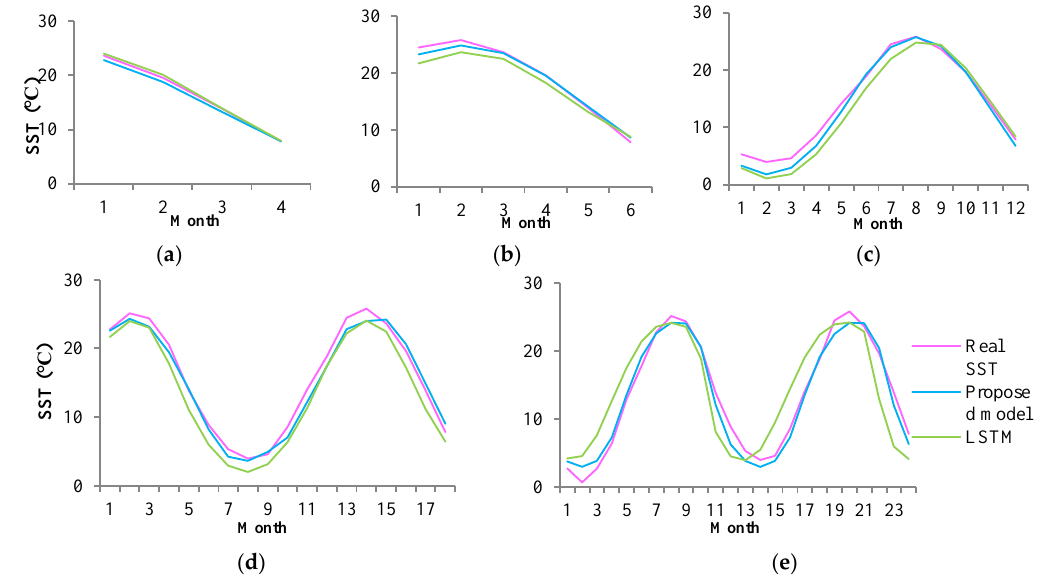
Figure 9. P2 prediction results for different time lengths. The horizontal axis is the predicted length